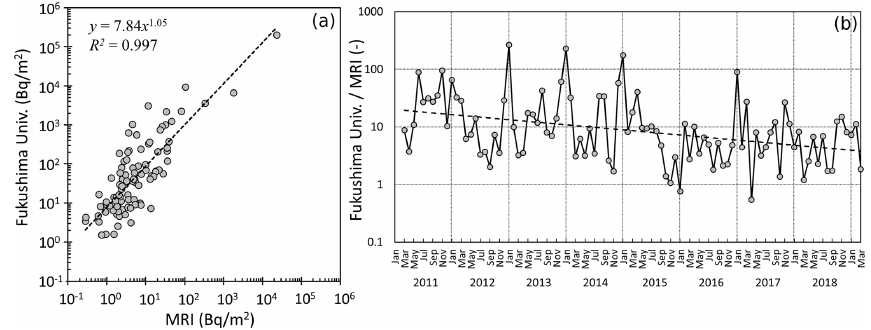
Figure 10. (a) Scatterplot of the observed surface deposition of 137 Cs at Fukushima University and the MRI from March 2011 to March 2019, with a regression line. (b) Time series of the ratio of deposition at Fukushima University to deposition at the MRI, with a regression line.